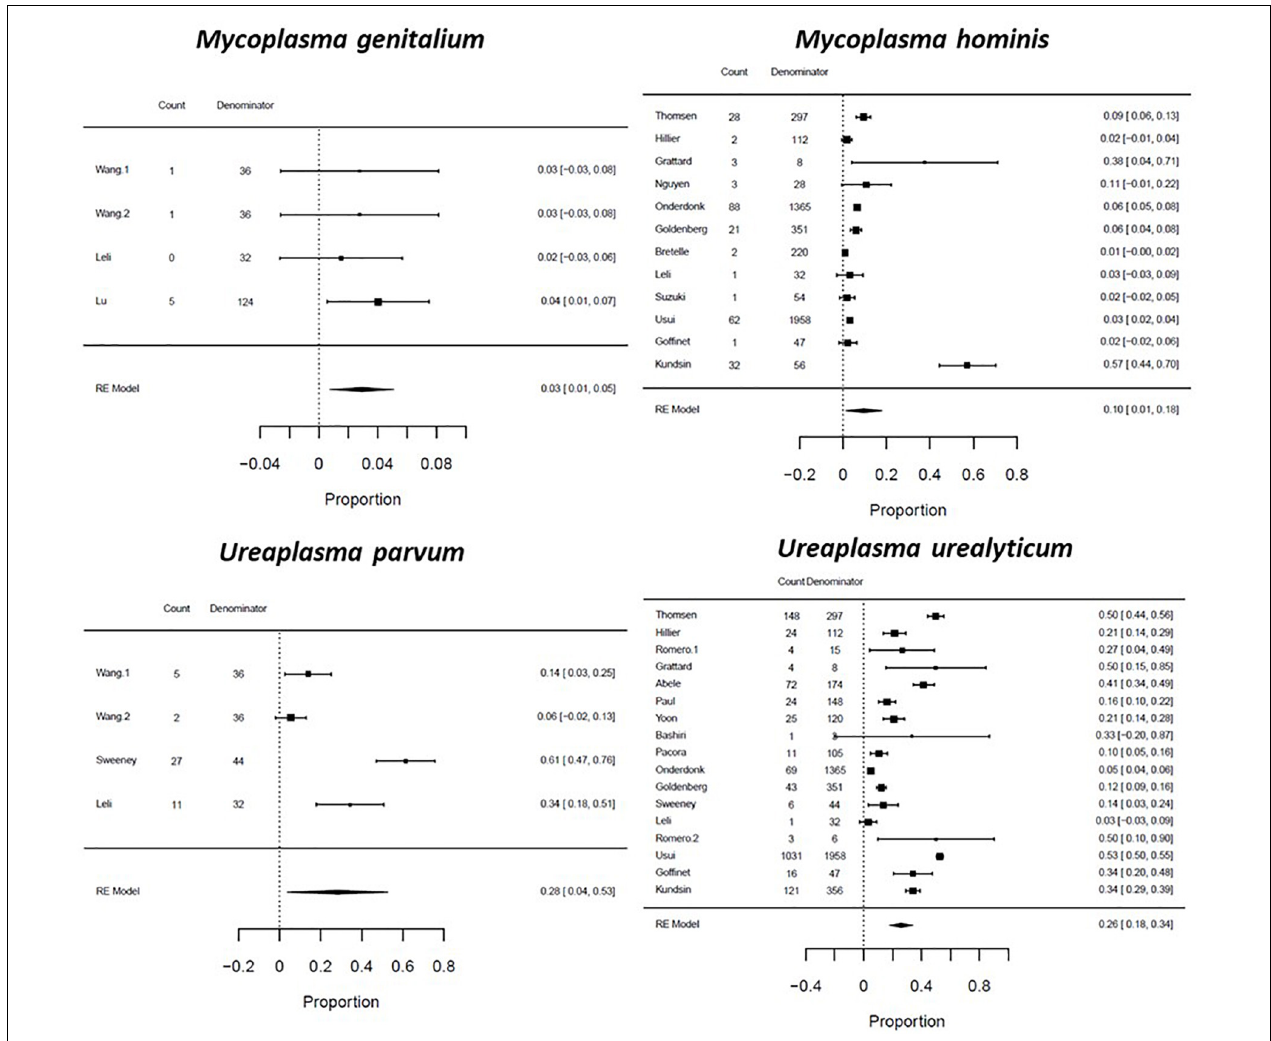
FIGURE 4 | Forest plot for the pooled proportion of genital Mycoplasma infection among preterm birth